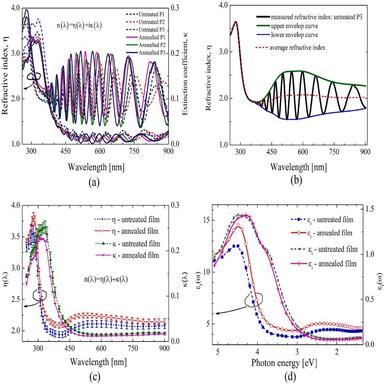
Dispersive refractive indexes of ITO films before and after annealing recorded at (a) three locations on the untreated (dashed-line) and annealed (solid-line) films, (b) envelop curve adapted to Fig. 8(a), (c) average value of the dispersive refractive index, and (d) value of the dispersive complex dielectric constant.